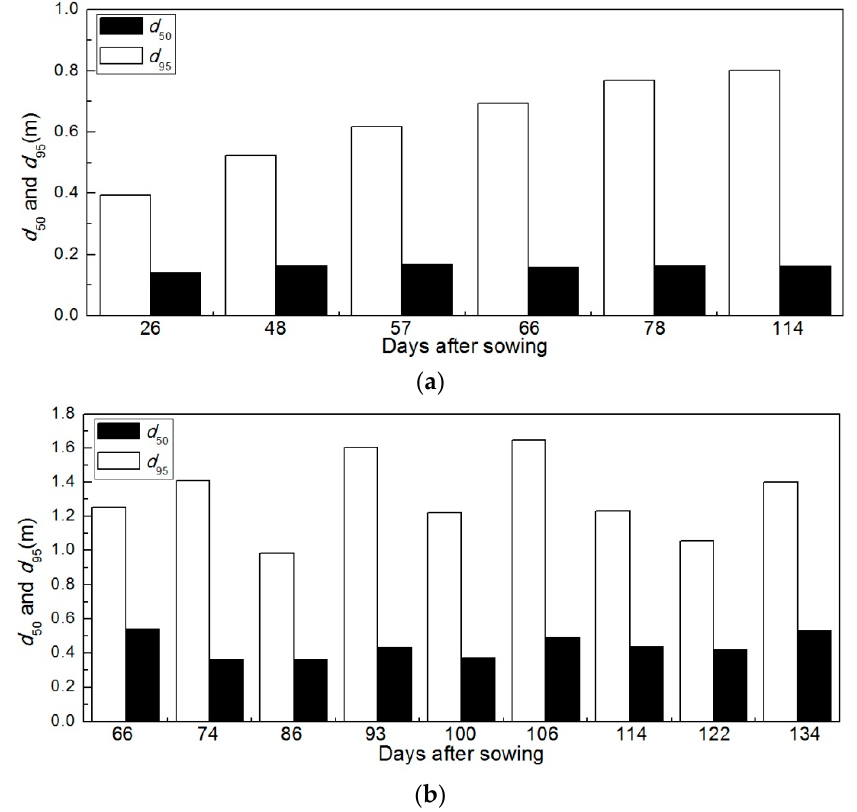
Figure 3. The root distribution parameters d 50 (black) and d 95 (white) calculated with root biomass data measured in 2006 ( a ) and root length density data measured in 2012 ( b ).